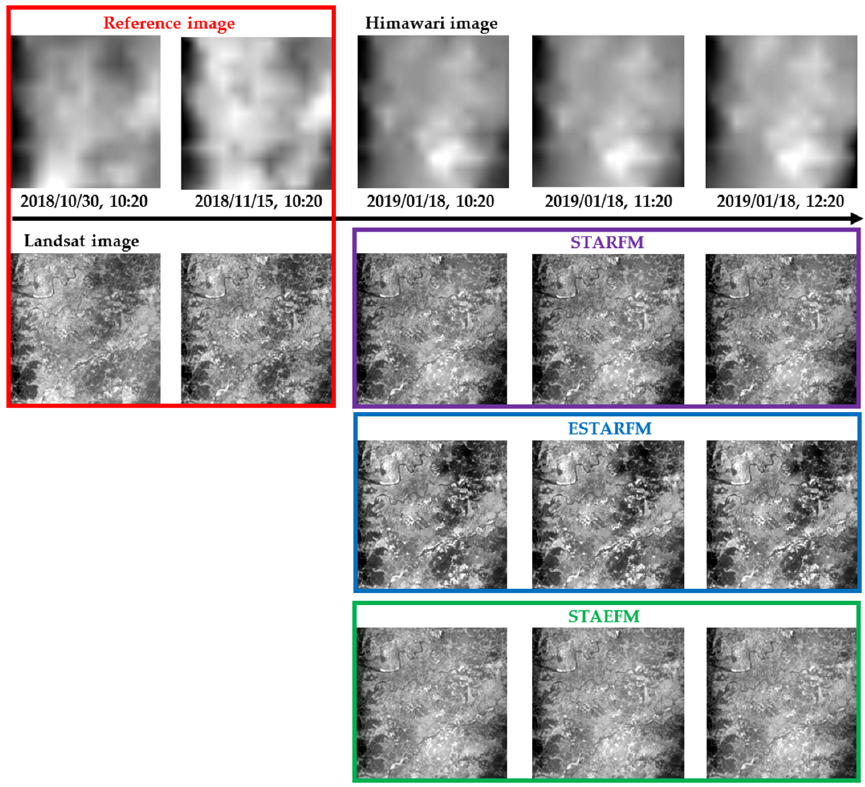
Figure 4. Results of fused TIR images from STARFM, ESTARFM, and STAEFM approaches .